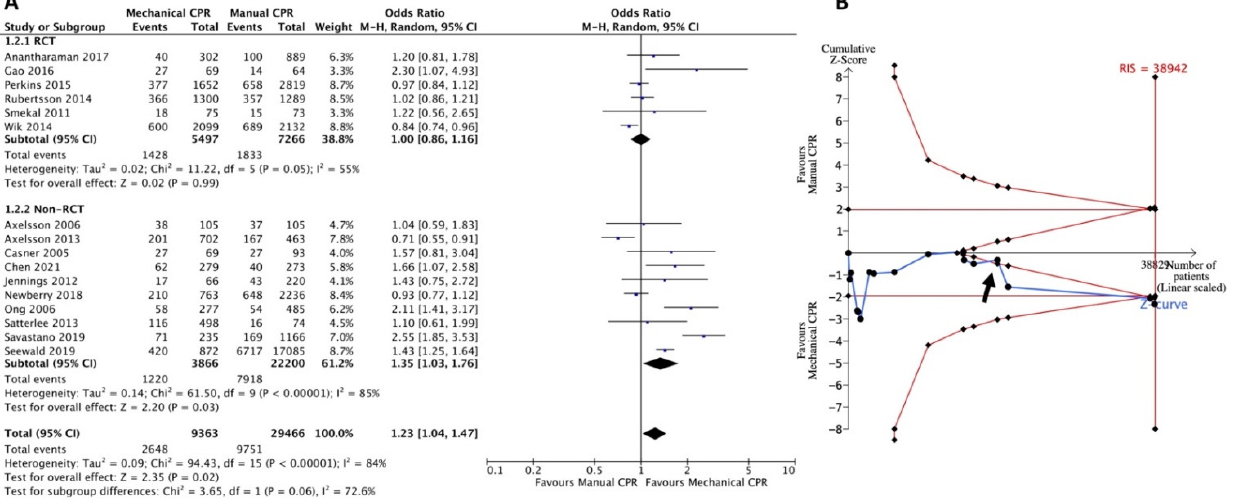
Figure 3. Forest plot ( A ) and trial sequential analysis ( B ) for survival to hospital admission between mechanical CPR device and manual CPR. CPR: cardiopulmonary resuscitation; CI: confidence interval; RCT: randomized controlled trial; RIS: required information size.